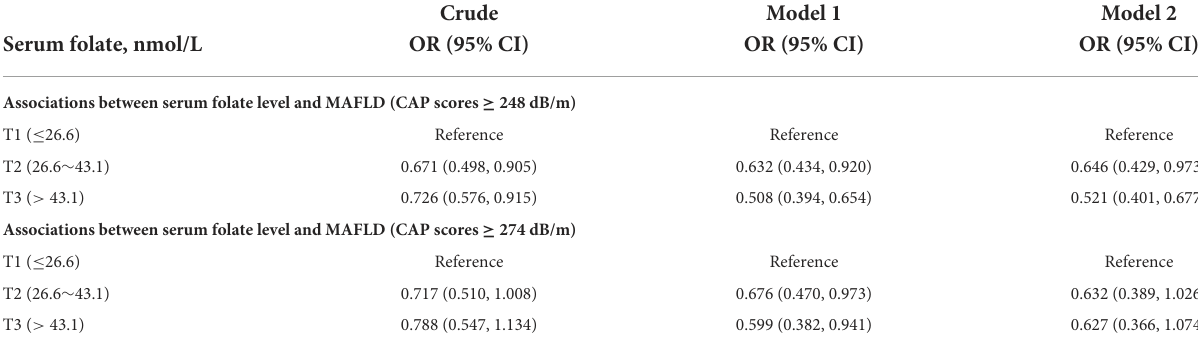
TABLE 2 Associations between serum folate levels and MAFLD. Crude Model 1 Model 2 Serum folate, nmol/L OR (95% CI) OR (95% CI) OR (95% CI) Associationsbetweenserum folate level and MAFLD (CAP scores ≥ 248 dB/m) T1 ( ≤ 26.6)